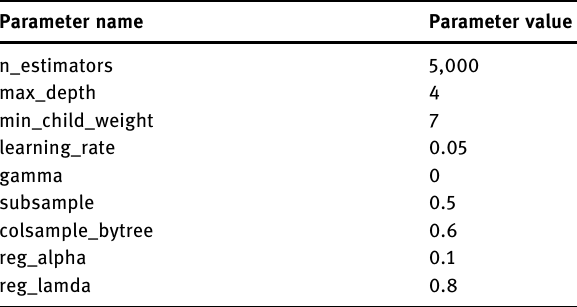
Table 4: Optimized parameters of the XGBoost model for e